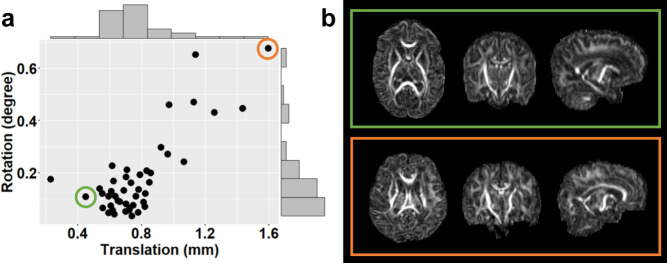
Overall small motion in diffuson magnetic resonance imaging scans of the studied population.(a) Scatter plot and histogram of rotation and translation measurements of d﻿iffusion magnetic resonance imaging scans from the 46 neonates who had a neurodevelopmental assessment at 2 years of age. (b) Axial, coronal, Axial, coronal, and sagittal views of the fractional anisotropy (FA) maps from two representative neonates with relatively small (upper panel) and large (lower panel) motion among the cohort, corresponding to the two dots with green and orange circle in panel a, respectively. FA maps of both neonates demonstrate high signal-to-noise-ratio and good contrasts.